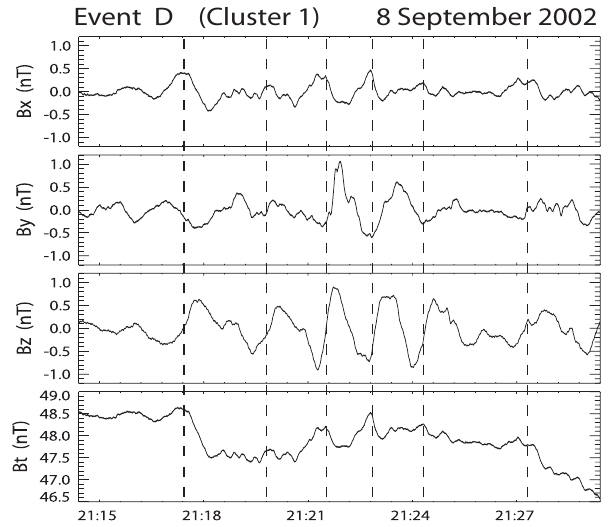
Fig. 4. Magnetic field data for event D. The components B x , B y and B z were averaged (40s) and detrended (150s). Vertical dashed lines are visual